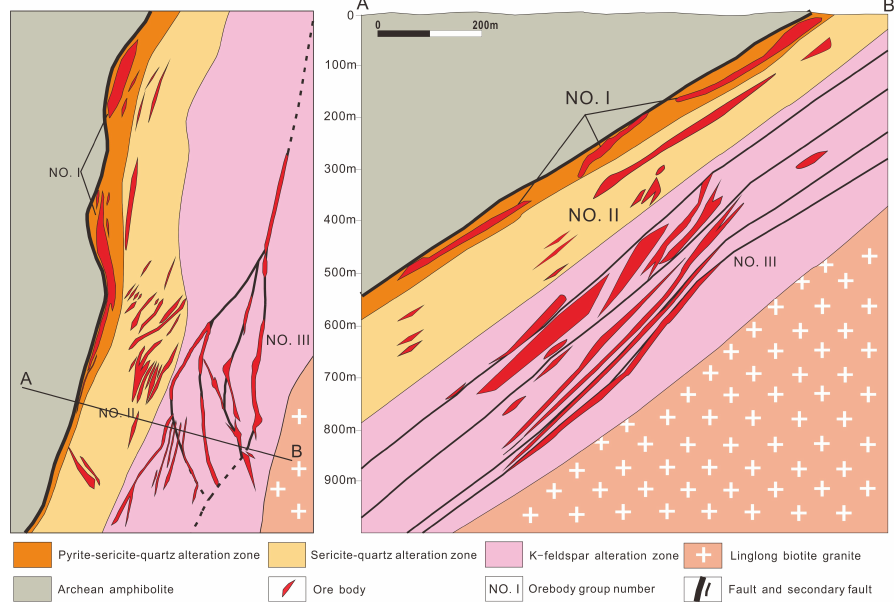
Figure 3. A sketch map of the Sizhuang gold deposit showing the orebodies and hydrothermal alteration: ( a ) The plan view of the Sizhuang deposit and ( b ) the geological cross sections along lines AB. The orebody was defined by the gold cut-off grade (1